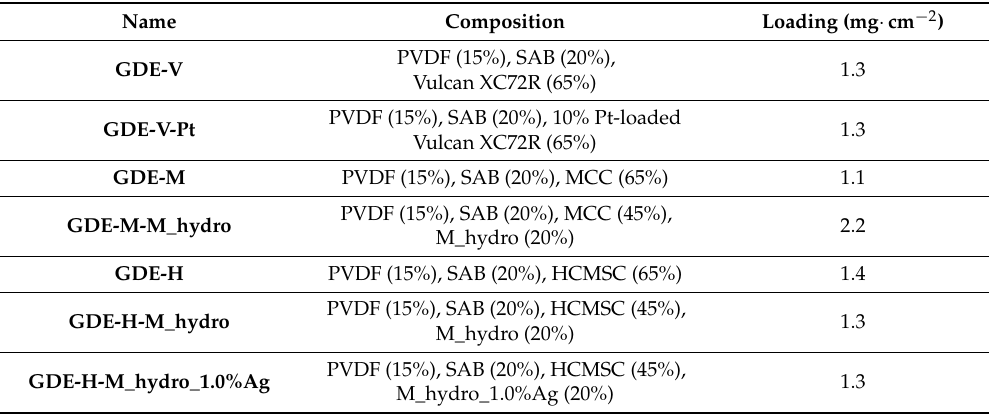
Table 2. Investigated gas diffusion electrodes (GDEs) with the relevant chemical compositions and active material loading. H: HCMSC (hollow core mesoporous shell carbon); M: MCC